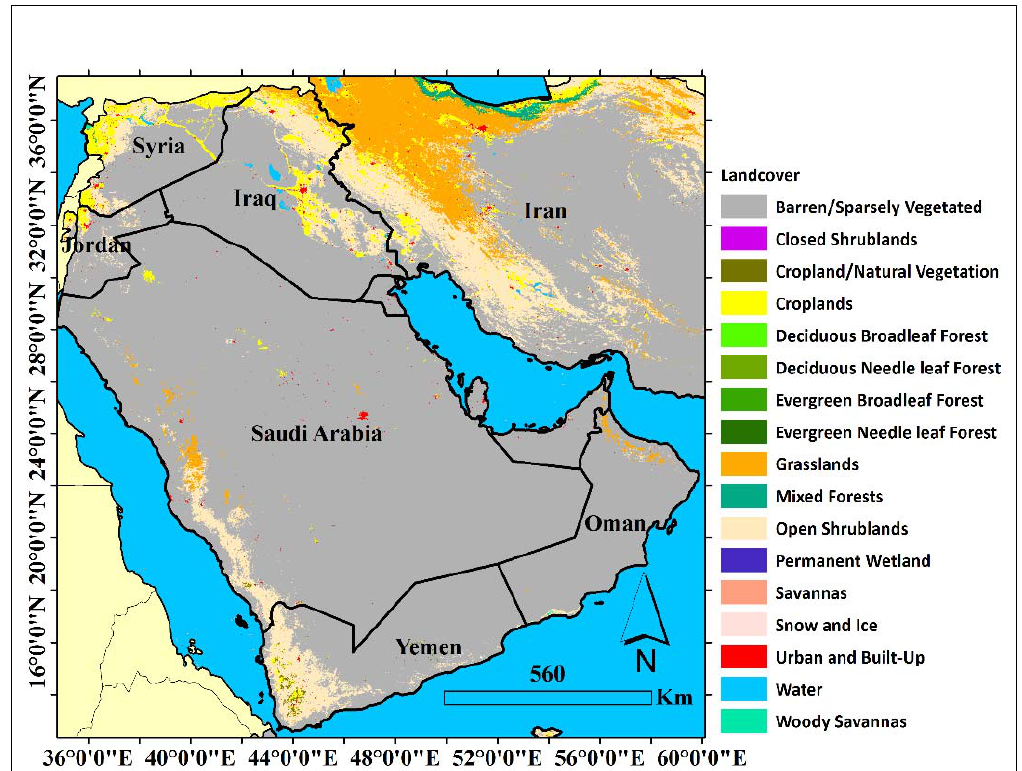
Figure 1. The geographic location of the study area is provided by USGS Land Cover Institute (https://www.usgs.gov) (accessed on 10 June 2021 ).